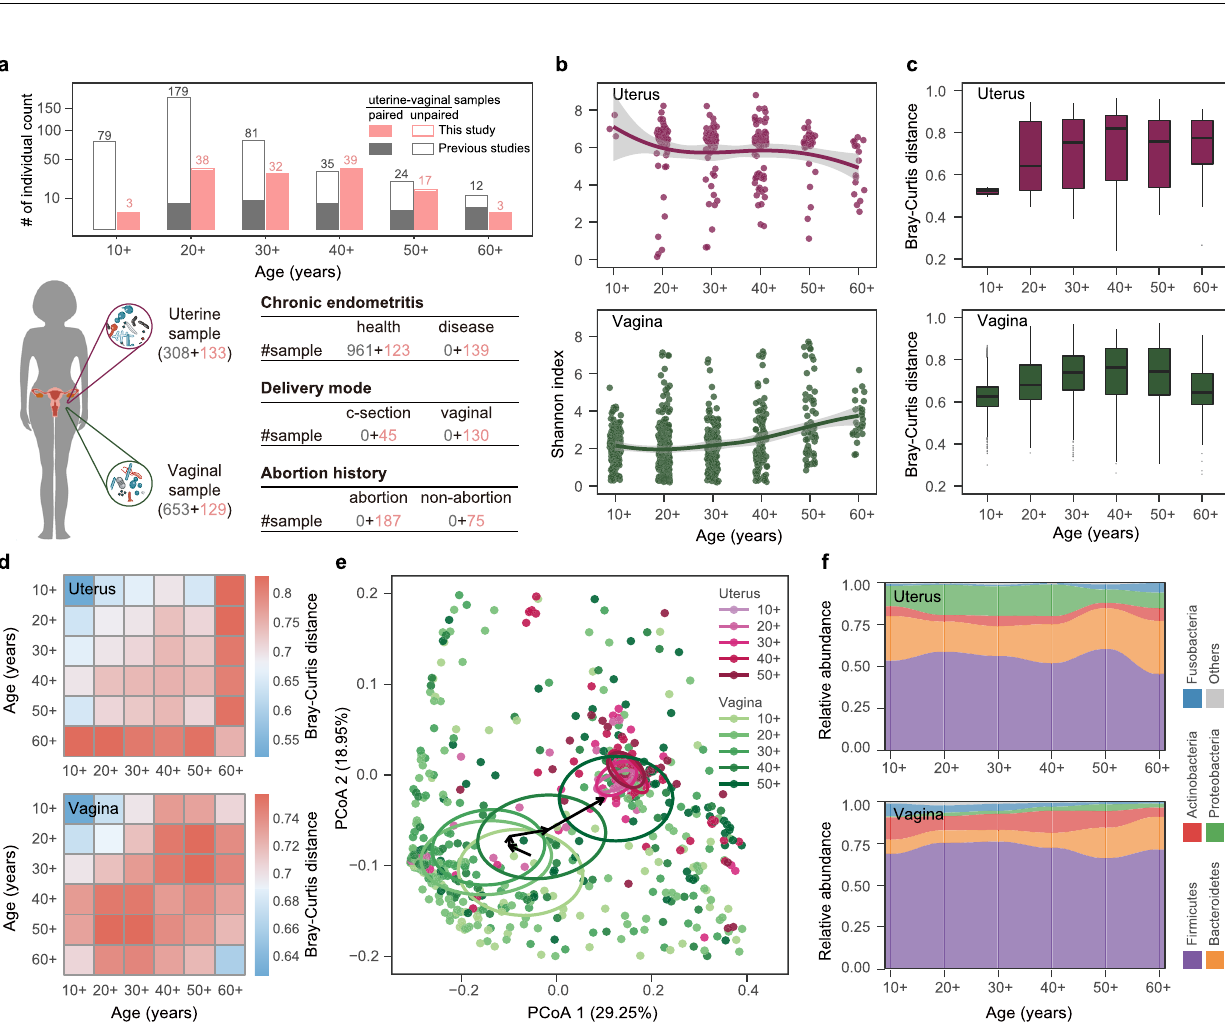
Fig. 1 Cohort overview and variations in uterine and vaginal microbiome associated with aging. a The age distribution of women and the number of samples in different groups in this study. Gray bars, red bars, hollow bars, and solid bars represent women from previous studies, from this study, with single uterine or vaginal sample types, and with paired uterine-vaginal sample types, respectively. The number of samples in each age group is given on the bar. The number of sequenced samples from the uterus and vagina and information on chronic endometritis, delivery mode, and abortion history are shown in brackets and tables. Red and gray numbers indicate the samples collected in this study and in previous studies, respectively. b Microbial diversities of the uterine and vaginal microbiome in women of different ages. The scales 10 + , 20 + , 30 + , 40 + , 50 + , and 60 + on the x -axis represent ages <20, 20 – 29, 30 – 39, 40 – 49, 50 – 59, and ≥ 60 years, respectively. The shadow around the linear regression trendline shows the 95% con fi dence interval (CI). c The Bray- Curtis (BC) distance of the microbial communities among individuals of the same age group. Box-plot elements are de fi ned as: center line, median; box limits, upper and lower quartiles; whiskers, 1.5× interquartile range; points, outliers. d The BC distance of the microbial communities among individuals within the same age group and between different age groups. e Principal coordinate analysis (PCoA) of the uterine and vaginal microbiome at each age stage. Each circle shows a 10% CI of each age group, and the arrow connects the vertical center of each circle. f The bacterial abundance of the uterine and vaginal microbiome at the phylum level, with different colors correspond to different